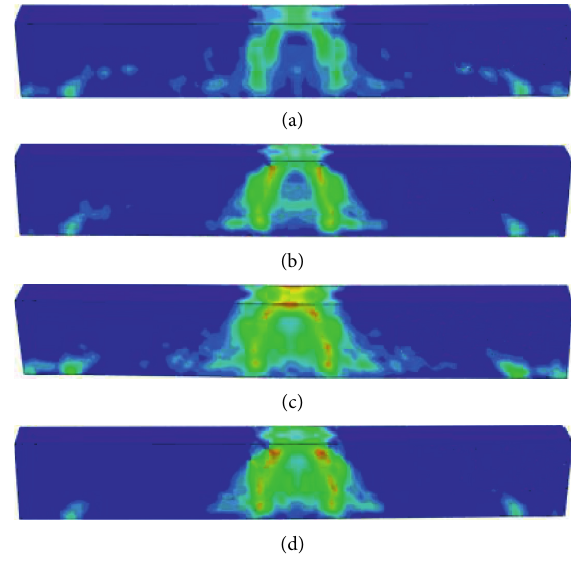
Figure 16: Local compressive damages: (a) L16-3-C, (b) L16-2-C,